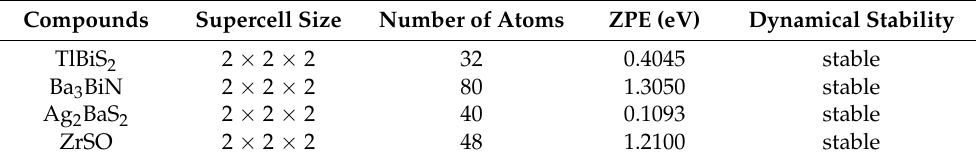
Table 3. Computational details for the phonon calculation (supercell size, number of atoms), calculated zero-point energy (ZPE) and information on dynamical stability based on phonon density of states for TlBiS 2 , Ba 3 BiN, Ag 2 BaS 2 , and ZrSO phases.